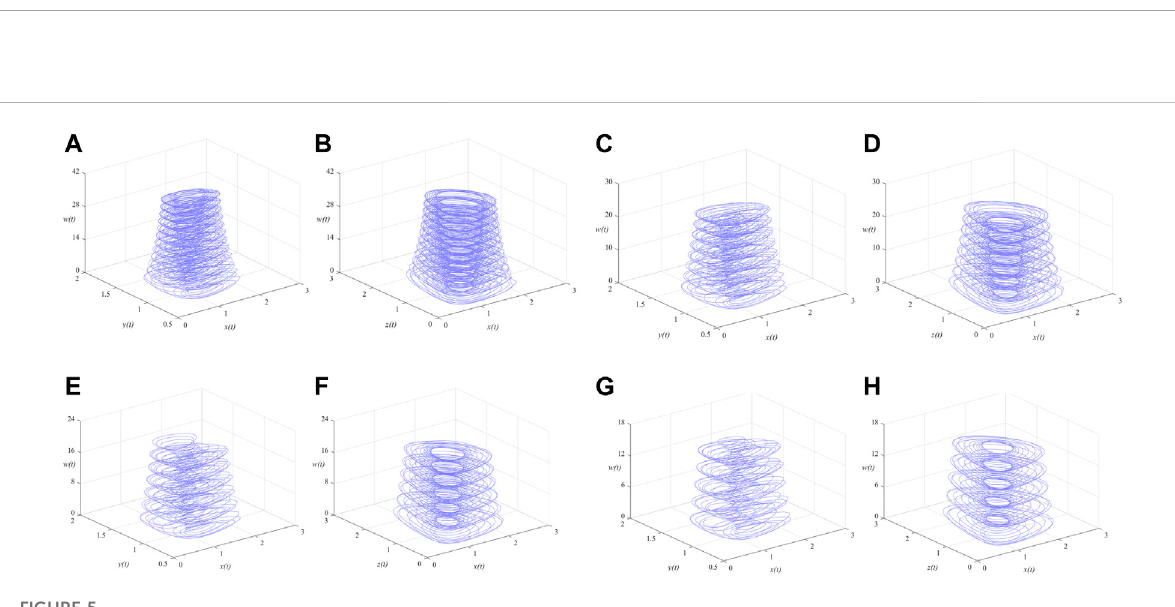
FIGURE 5 Phase portraits of the MSMFrLVS in x - y - w space and x - z - w space: (A,B) : α ′ i (cid:4) 0 . 7, (C,D) : α ′ i (cid:4) 0 . 8, (E,F) : α ′ i (cid:4) 0 . 85, (G,H) : α ′ i (cid:4) 0 . 9